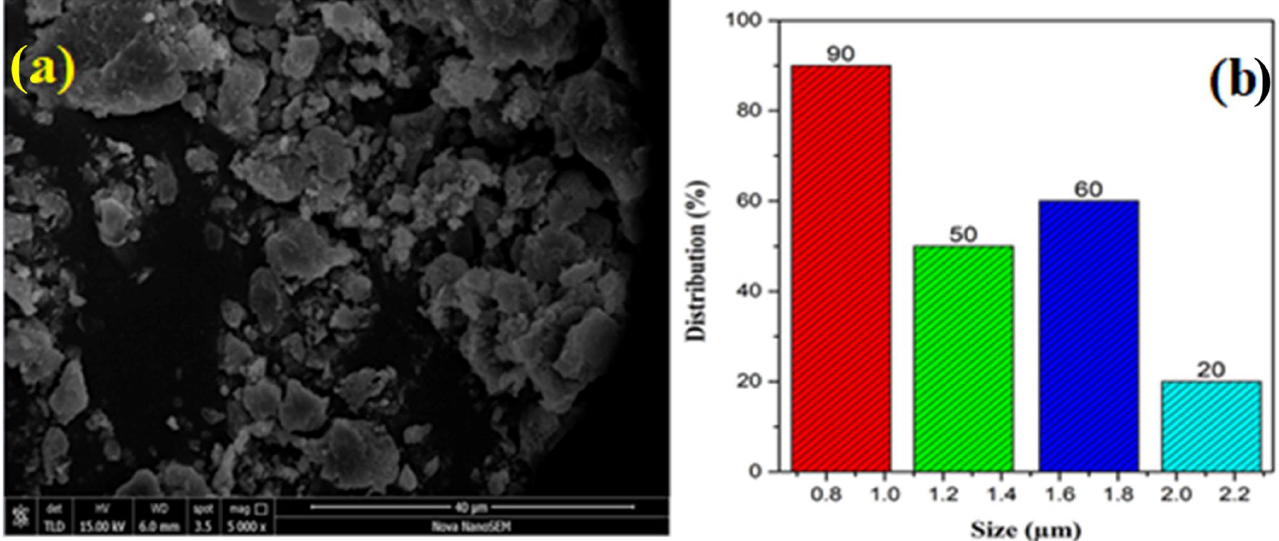
Figure 2. SEM image ( a ) and size distribution ( b ) of biogenic CuO